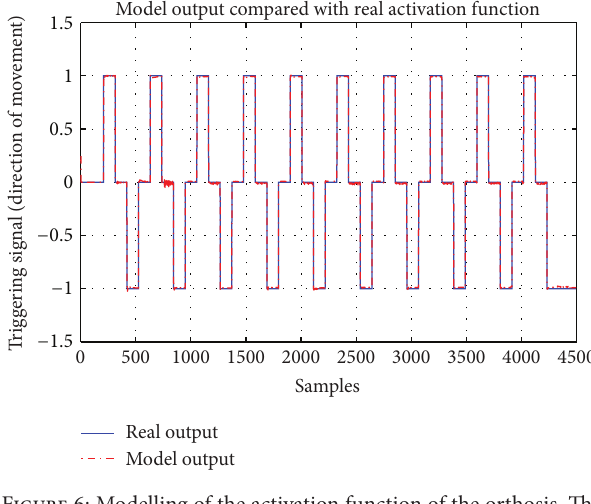
Figure 6: Modelling of the activation function of the orthosis. The real function (blue) is compared with the modelled function (red). Model fit reaches over 99%. In this example the orthosis was fixed at 90 ∘ angular